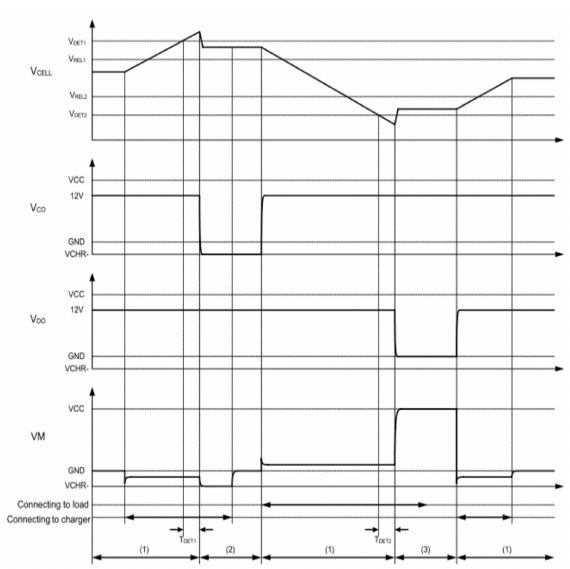
Figure A5. Operation Timing chart during Overcharge / Over-discharge Protection with